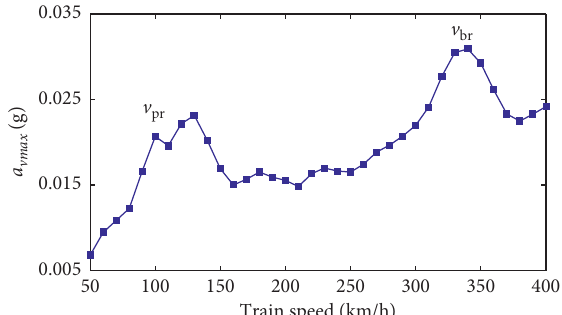
Figure 6: Maximum car body accelerations versus train speed.